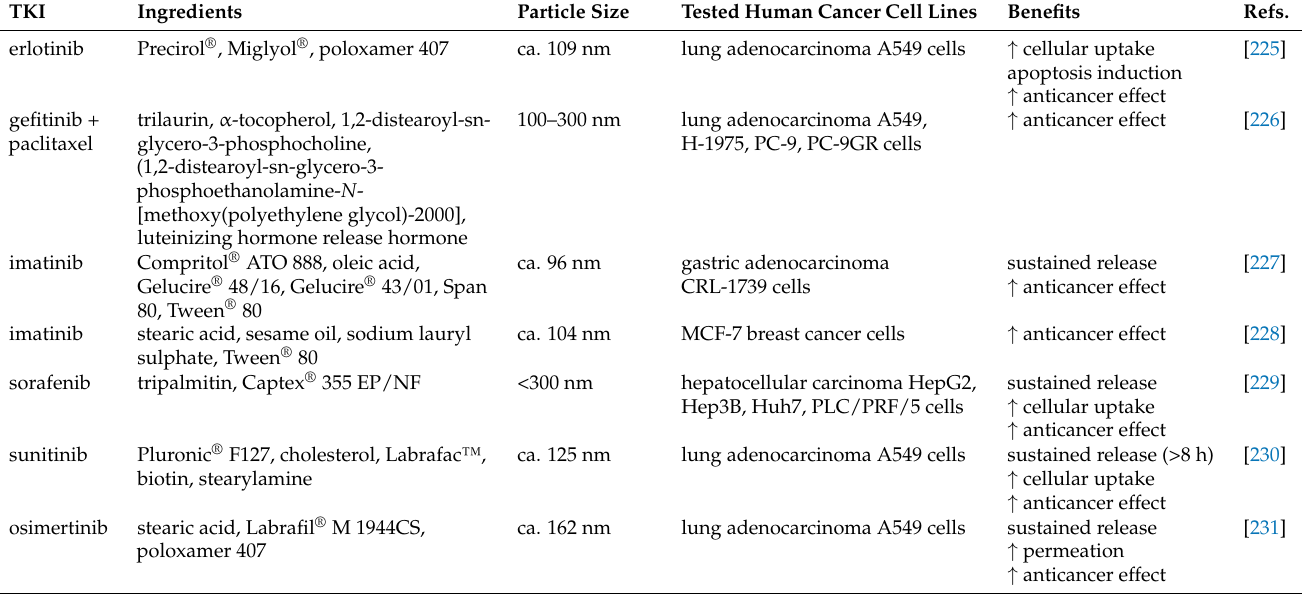
Table 5. In Vitro tested NLC-based TKI